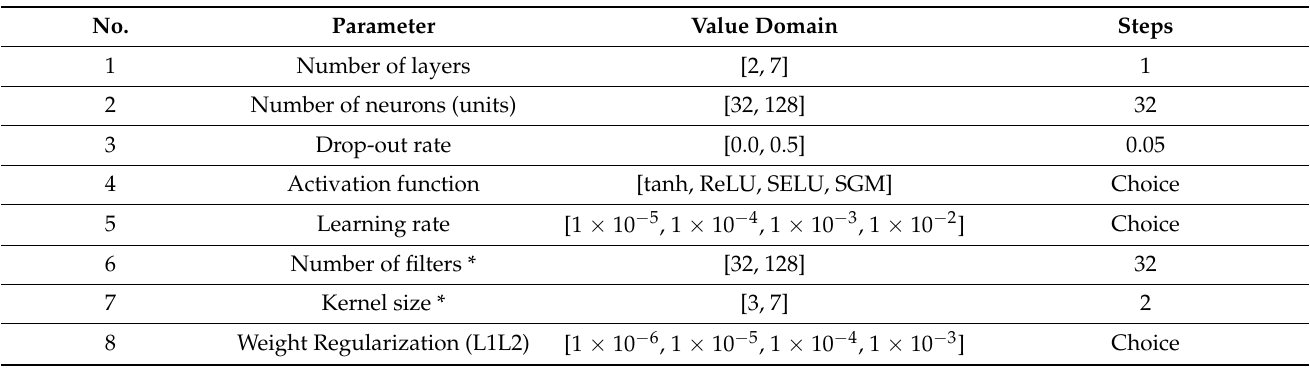
Table 1. The parameter spaces used in Keras tuner for the deep learning models used in this